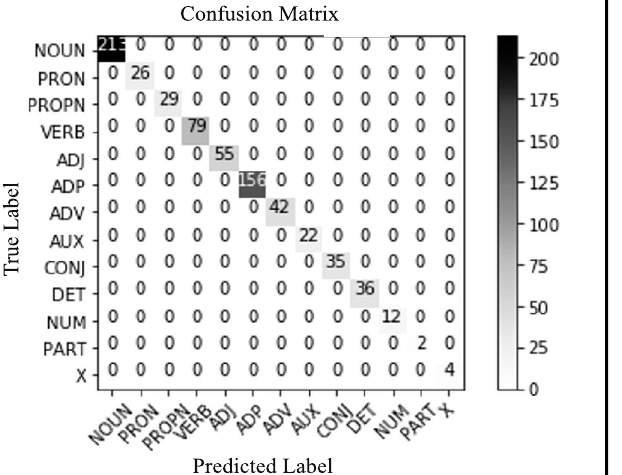
FIG. 6. CONFUSION MATRIX, DERIVED THROUGH RANDOM FOREST ALGORITHM TARGETING CLASS UPOS